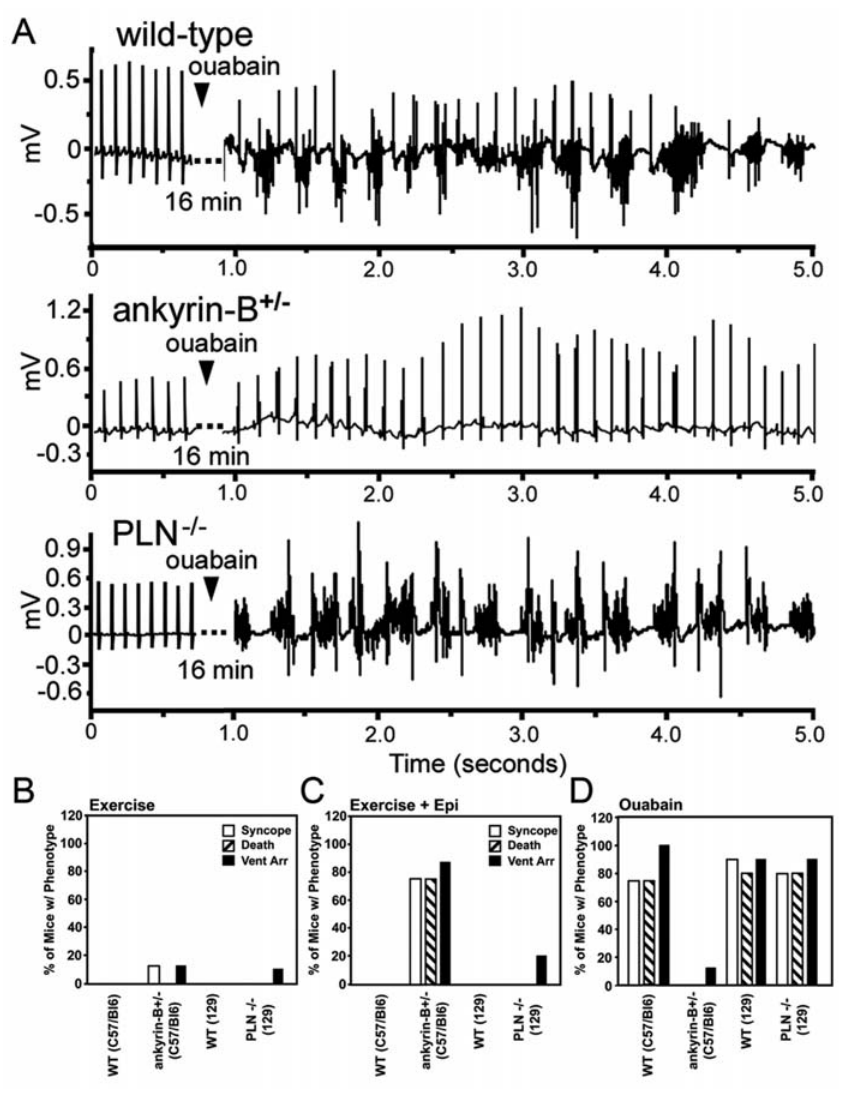
Figure 3. Ankyrin-B + / 2 mice are resistant to ouabain-induced ventricular arrhythmia and death. Wild-type (n=8) and ankyrin-B + / 2 mice (n=8), and wild-type (n=10) and phospholamban-null mice (n=10) were surgically-implanted with radiotelemetry ECG probes. Mice were injected with a high dose (10 mg/kg) of ouabain or 2 mg/kg epinephrine, and conscious ECGs were recorded. Unlike wild-type or phospholamban-null mice, ankyrin-B + / 2 mice display resistance to ouabain-induced ventricular arrhythmia (1/8) and death (0/8). Panel A represents ECG data from wild-type, ankyrin-B + / 2 , and PLN null mice treated with ouabain. Data in panels B–D represent summary syncope, death, and arrhythmia data for mice following exercise (panel B), exercise plus epinephrine injection (panel C), and ouabain injection (panel